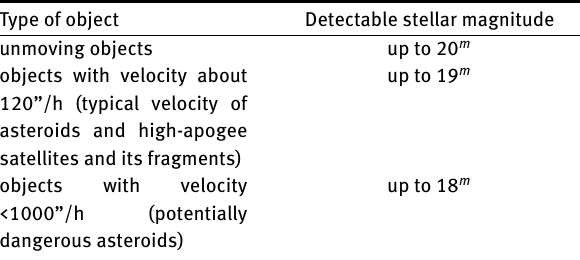
Table 2. Sensitivity of MASTER-Cosmos